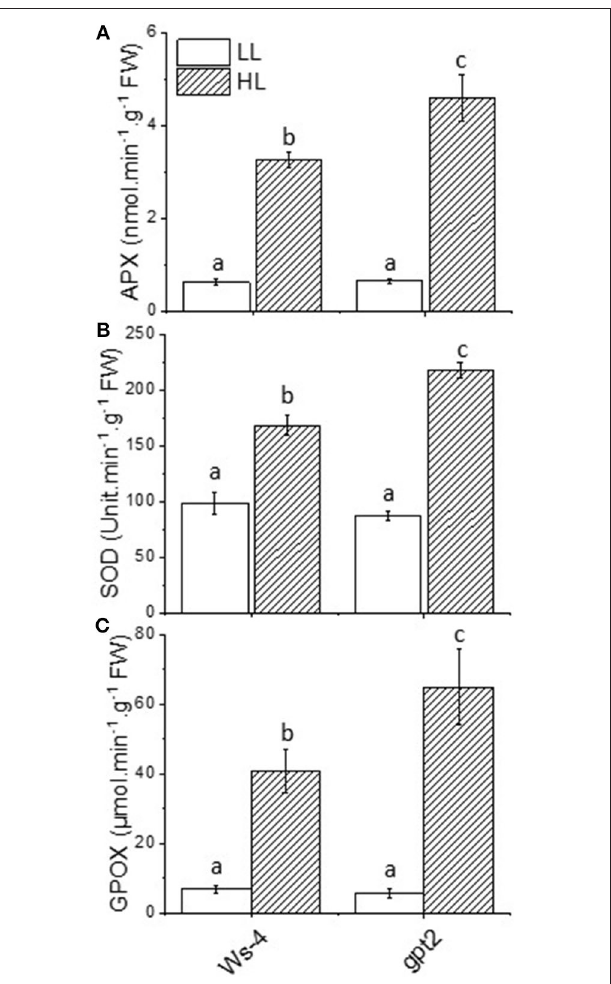
FIGURE 3 | Antioxidant enzyme activities in Ws-4 wild type and gpt2 plants. Enzymatic activity of ascorbate peroxidase (APX) (A) , superoxide dismutase (SOD) (B) , and guiacol peroxidase (GPOX) (C) in plants that were grown for 7 weeks at 100 µ mol m − 2 s − 1 light and then either maintained at 100 µ mol m − 2 s − 1 for 7 more days (LL) or transferred to conditions with an irradiance of 400 µ mol m − 2 s − 1 (HL). Samples were collected at mid-day on Day 7 of the treatment. The data were analysed using a two-way ANOVA followed by Tukey’s test at p ≤ 0.05 to be significantly different. Results are M ± SE of 6–9 independent replicates. Different lowercase letters denote significantly different values.